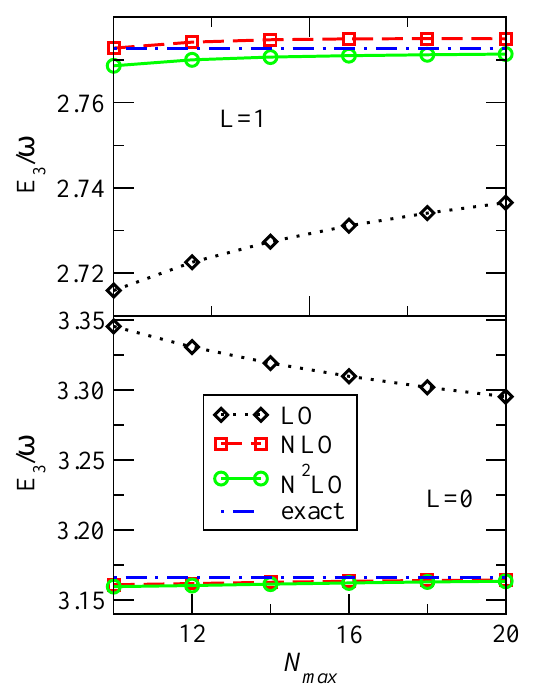
Fig. 4. The running of the lowest L = 0 (lower panel) and L = 1 levels at LO, NLO and N 2 LO. I have considered two-body inter- actions at unitarity ( b / a 2 = 0) with no range ( r 2 / b = 0).